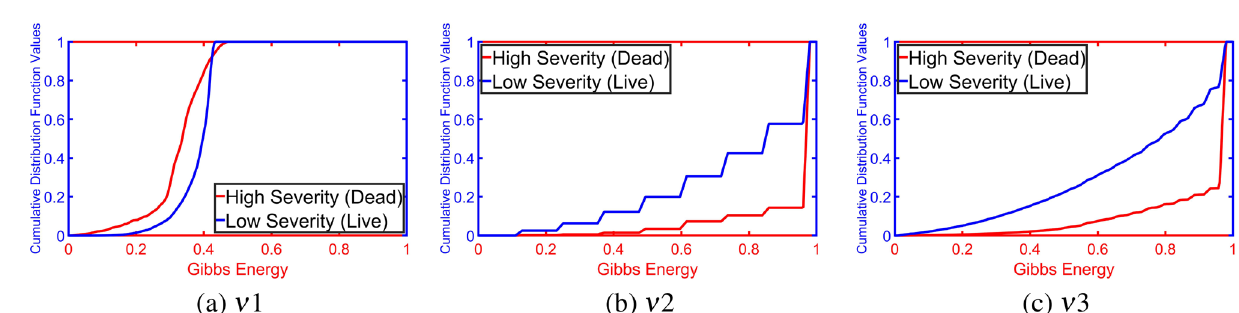
Figure 6. Estimated CDFs at three different radii for two different subjects at two different severity levels.